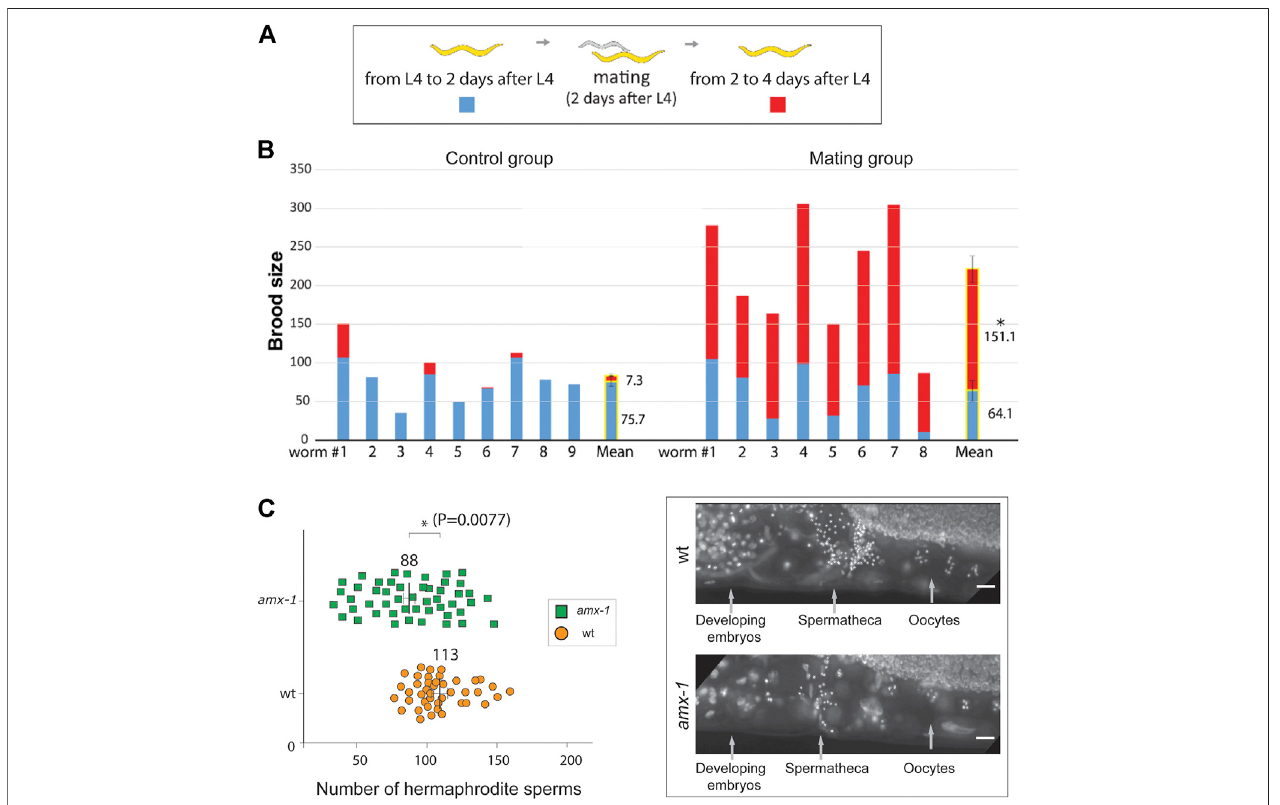
FIGURE4 | Mating rescuesthe SBS phenotype of amx-1 , retainingfewer sperms. (A) Schematic representation ofassay for determiningthe number ofprogenies before and after mating. We counted the number of progenies from the L4 stage worms for 4 days. Starting from L4 stages, we counted the number of progenies for 2 days. Thereafter, worms were mated with wild type and we continued to monitor the number of progenies for the following two more days. (B) Quanti fi cation of the number of brood sizes before and after mating. Individual worms and mean values of brood size with or without mating are shown. n = 9 for control and n = 8 for mating.Errorbarsrepresentstandarderrorsofthemean. (C) Left,quanti fi cationofthenumberofhermaphroditespermspergonadarm.Right,representativeimagesof theworms containingspermathecae. Rawdataisavailablein Supplementary FigureS1 .Errorbars represent standarderrorsofthemean. n =43forwildtypeand n = 48 for amx-1 . Asterisks indicate statistically signi fi cant changes by the two-tailed Man-Whitney test, 95% C.I. Bars, 10 μ m.